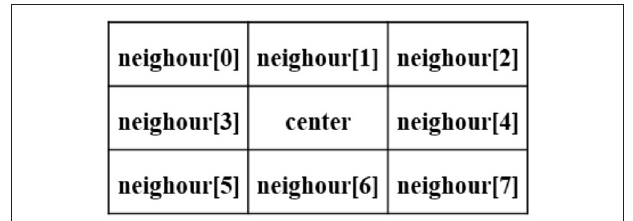
FIGURE 3 | Optimization based on a voting